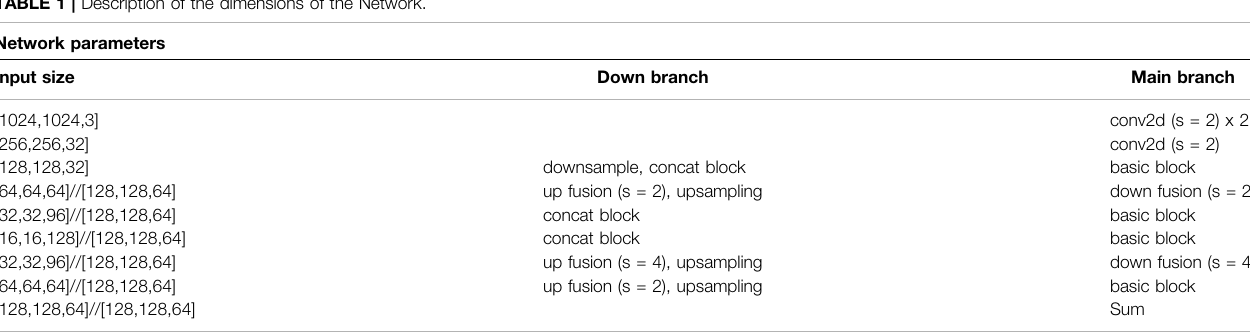
TABLE 1 | Description of the dimensions of the